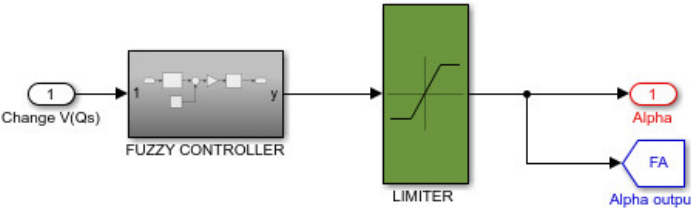
Figure 3. TSC-TCR 3-phase circuit diagrams with grid connection concept.